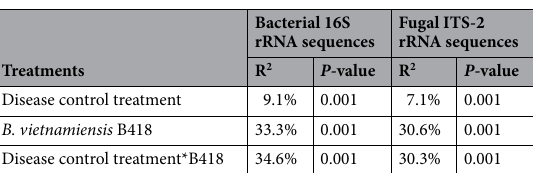
Table 2. Burkholderia vietnamiensis B418 and its interaction with other disease control treatments.